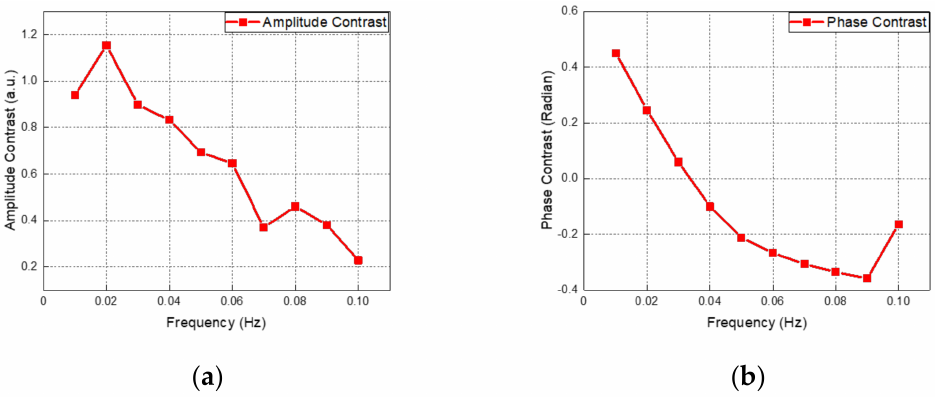
Figure 7. Plot of ROI contrast for optimum excitation frequency: ( a ) amplitude and ( b )